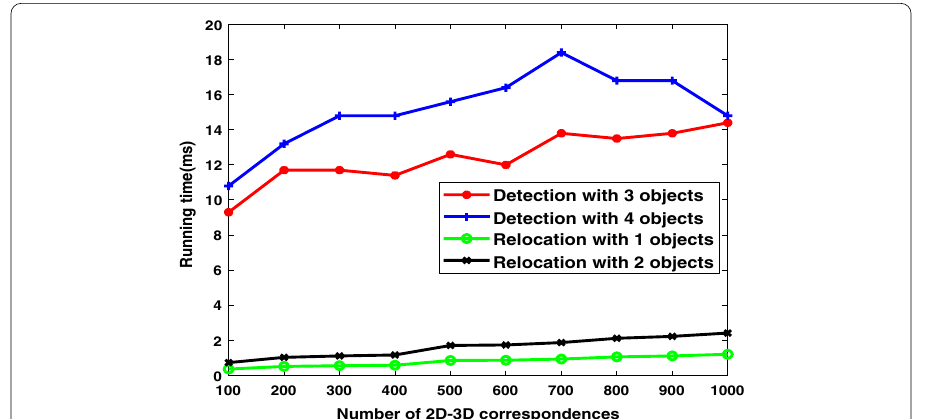
Fig. 14 Running time comparison of our proposed two methods with different displaced object w.r.t. number of 2D-3D correspondences